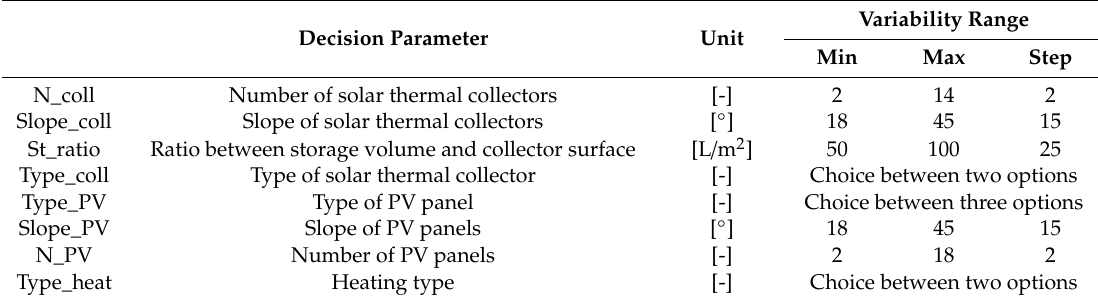
Table 3. Active decision parameters (systems) and related variability